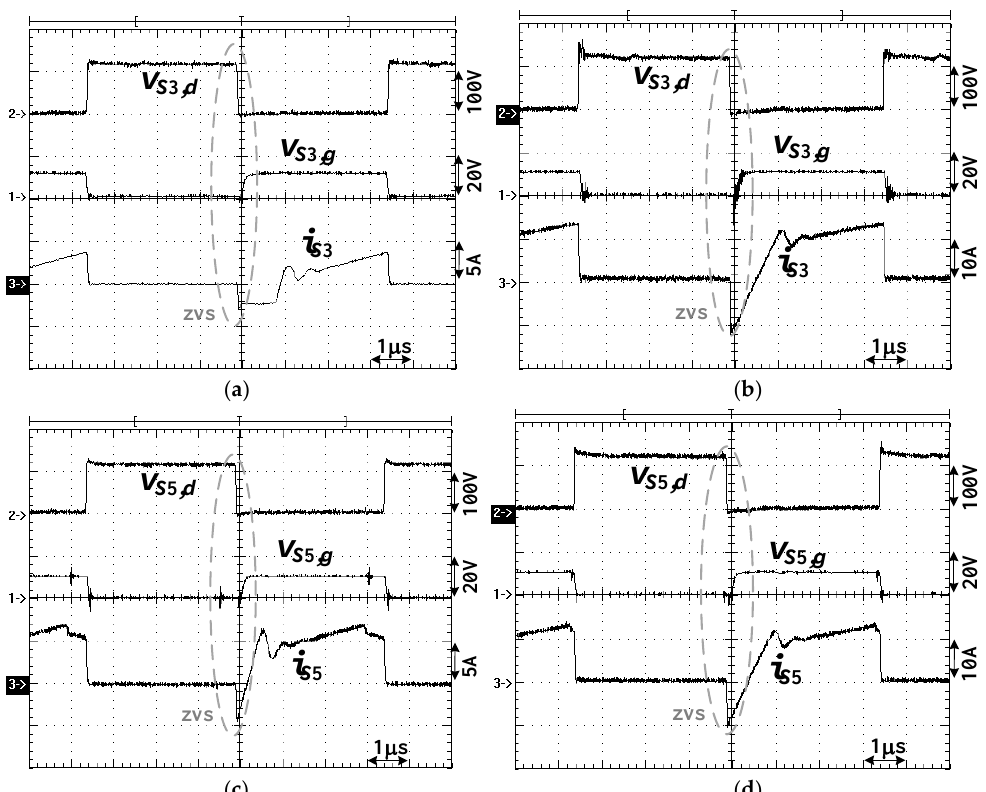
Figure 6. Test waveforms at V in = 120 V (low voltage input range) and P o = 800 W: ( a ) primary-side waveforms v S 3 ,g , v S 5 ,g , v bc , and i Lr 1 ; ( b ) secondary-side waveforms i D 1 , i D 2 , i Lo 1 , i Lo 2 , and i Lo 1 + i Lo 2 .